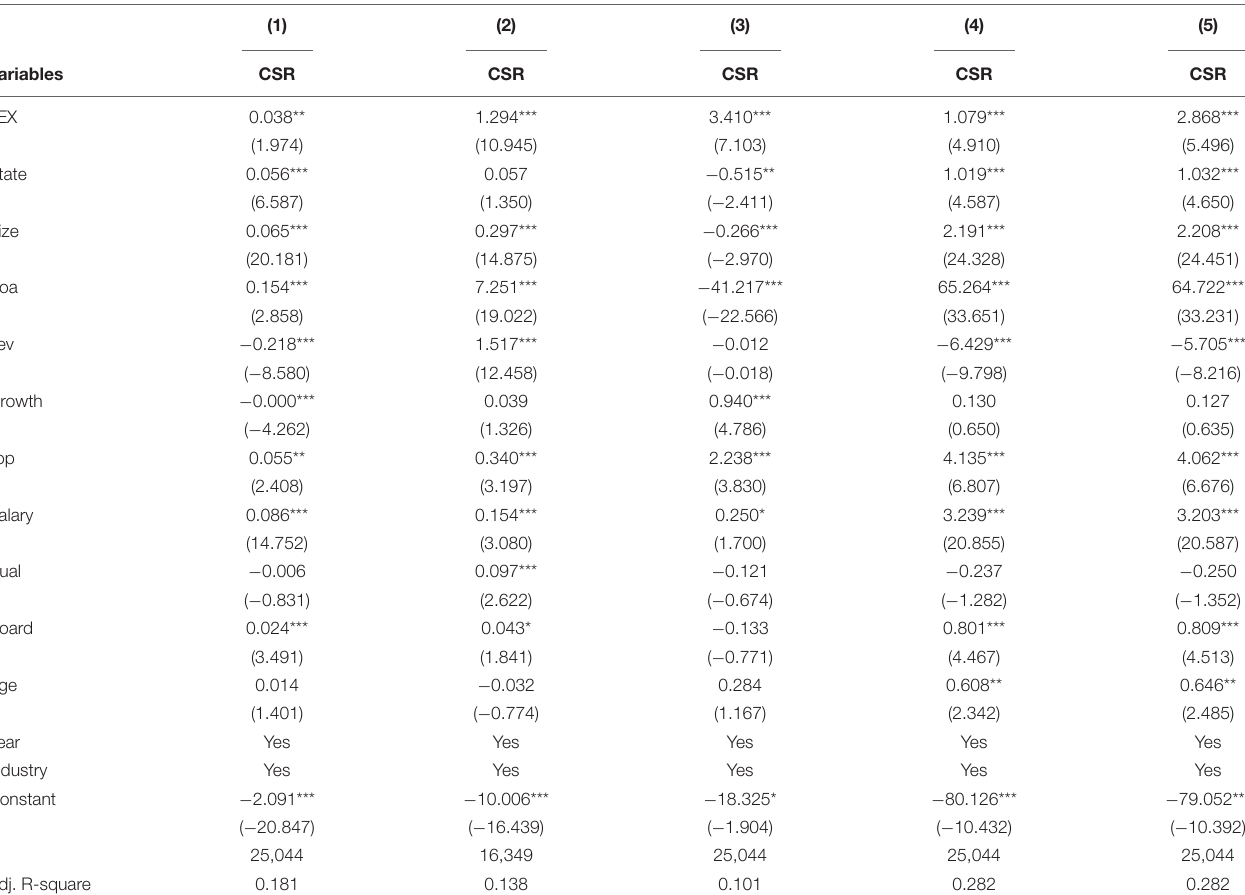
TABLE 8 | Replacing